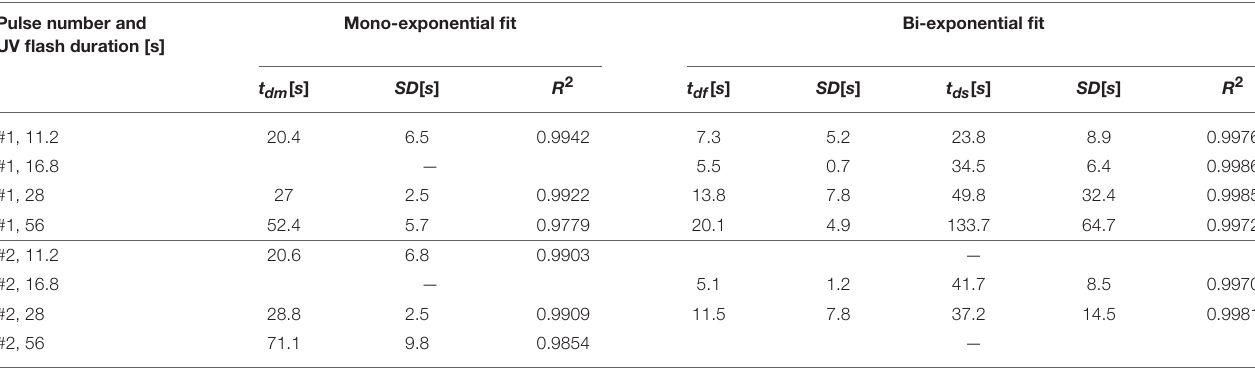
TABLE 1 | Mean, standard deviation, and coefficient of determination of the characteristic times derived from the monoexponential, t dm (Equation 5) and bi-exponential, t df and t ds (Equation 4) fits of the decaying part of the fluorescence, F k ( t ) (Equation 1), observed in oocytes for different UV flash durations. Pulse number and UV flash duration [s]